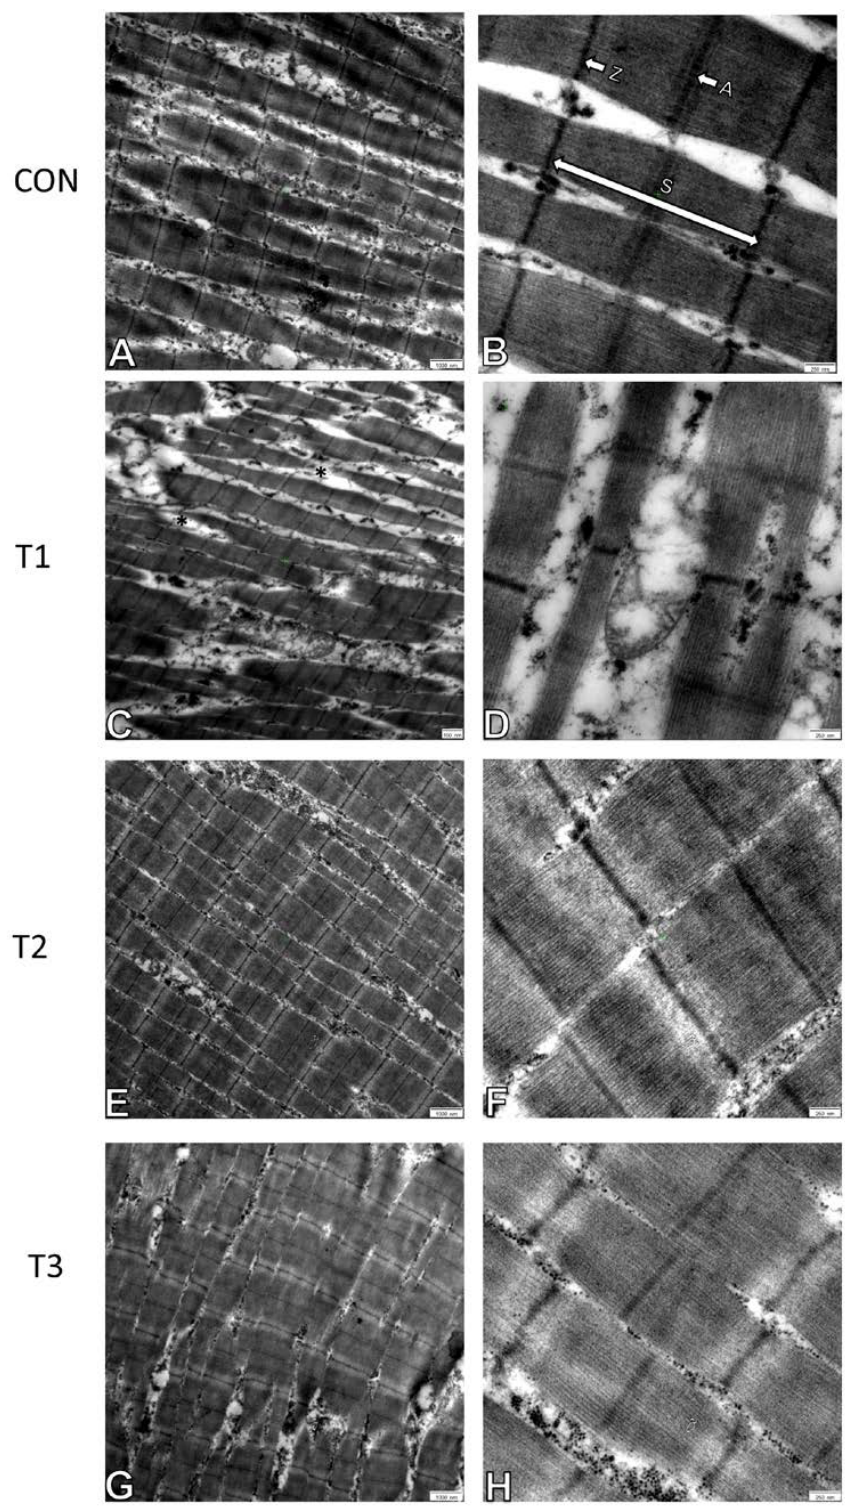
Figure 2. Ultrastructure of representative myofibers of the pectoral muscle of cockerels: CON—control group ( A , B ), T1—diet with upper dose of inorganic Se ( C , D ), T2—diet with upper dose of Se in the organic form ( E , F ), T3—diet with upper dose of Se in the form of nanoparticles ( G , H ). Scale bar 1000 nm ( A , C , E , G ) and 250 nm ( B , D , F , H ). S—sarcomere; A—A band; Z—Z band; *—indicates the disruption of